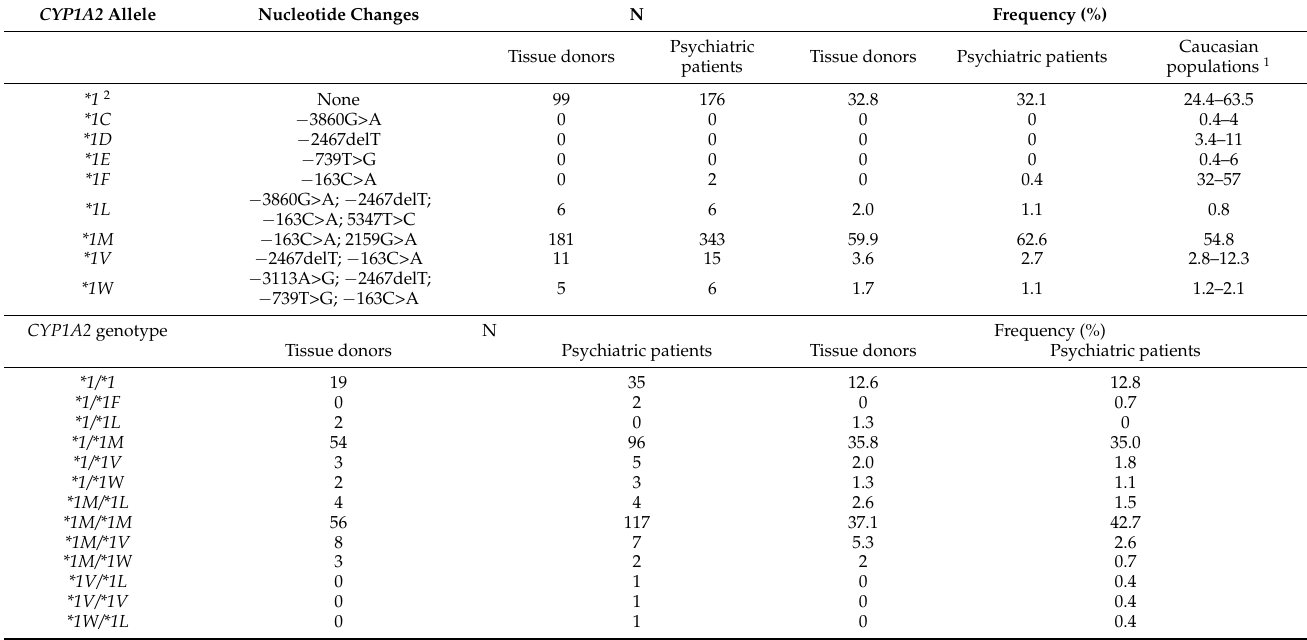
Table 2. CYP1A2 allele and genotype frequencies in the tissue donors, psychiatric patients and in Caucasian